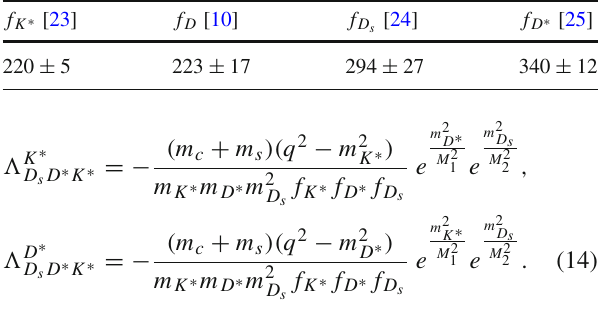
Table 1 The leptonic decay constants in